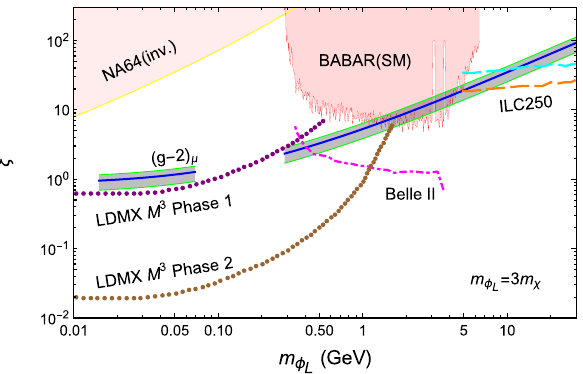
preferred by the L